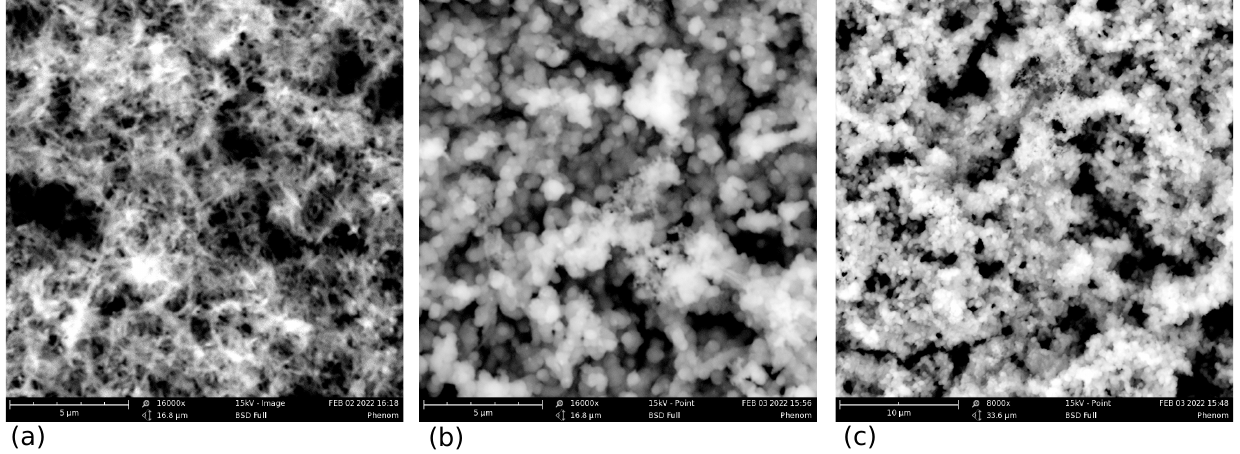
Figure 2. SEM images (top plan view) of the MWCNT array ( a ) and the array covered by single PANI layer ( b , c ). Scale bar: 5 µ m ( a ), 5 µ m ( b ) and 10 µ m ( c ). The electrolyte in our system is a solution of phosphoric acid H 3 PO 4 and polyvinyl alcohol (PVA). A schematic representation of the PANI/VA-MWCNT pseudocapacitor is shown in Figure 3a.